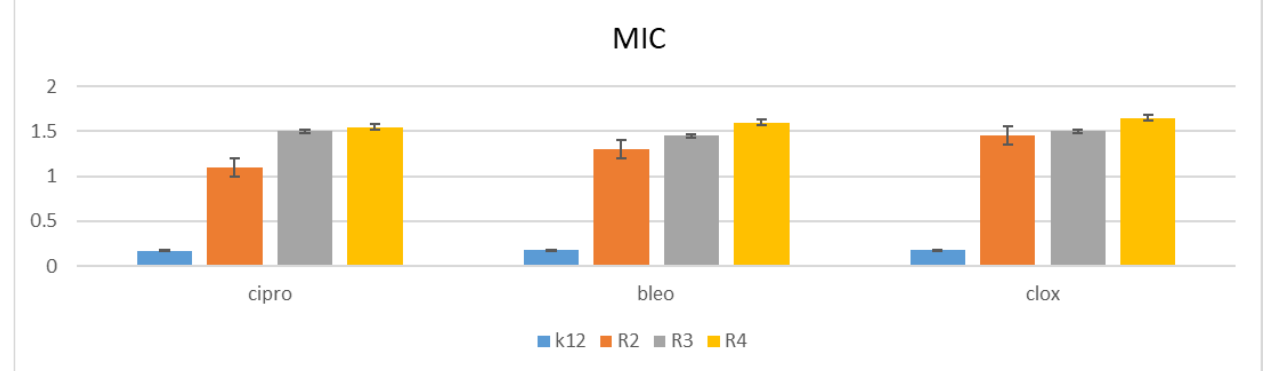
Figure 10. Examples of MIC with model bacterial strains K12, R2, R3, and R4 for studying antibiotics ciprofloxacin (cipro), bleomycin (bleo), and cloxacillin (clox). The x -axis features antibiotics used sequentially. The y -axis features the MIC value in µg/mL − 1 .